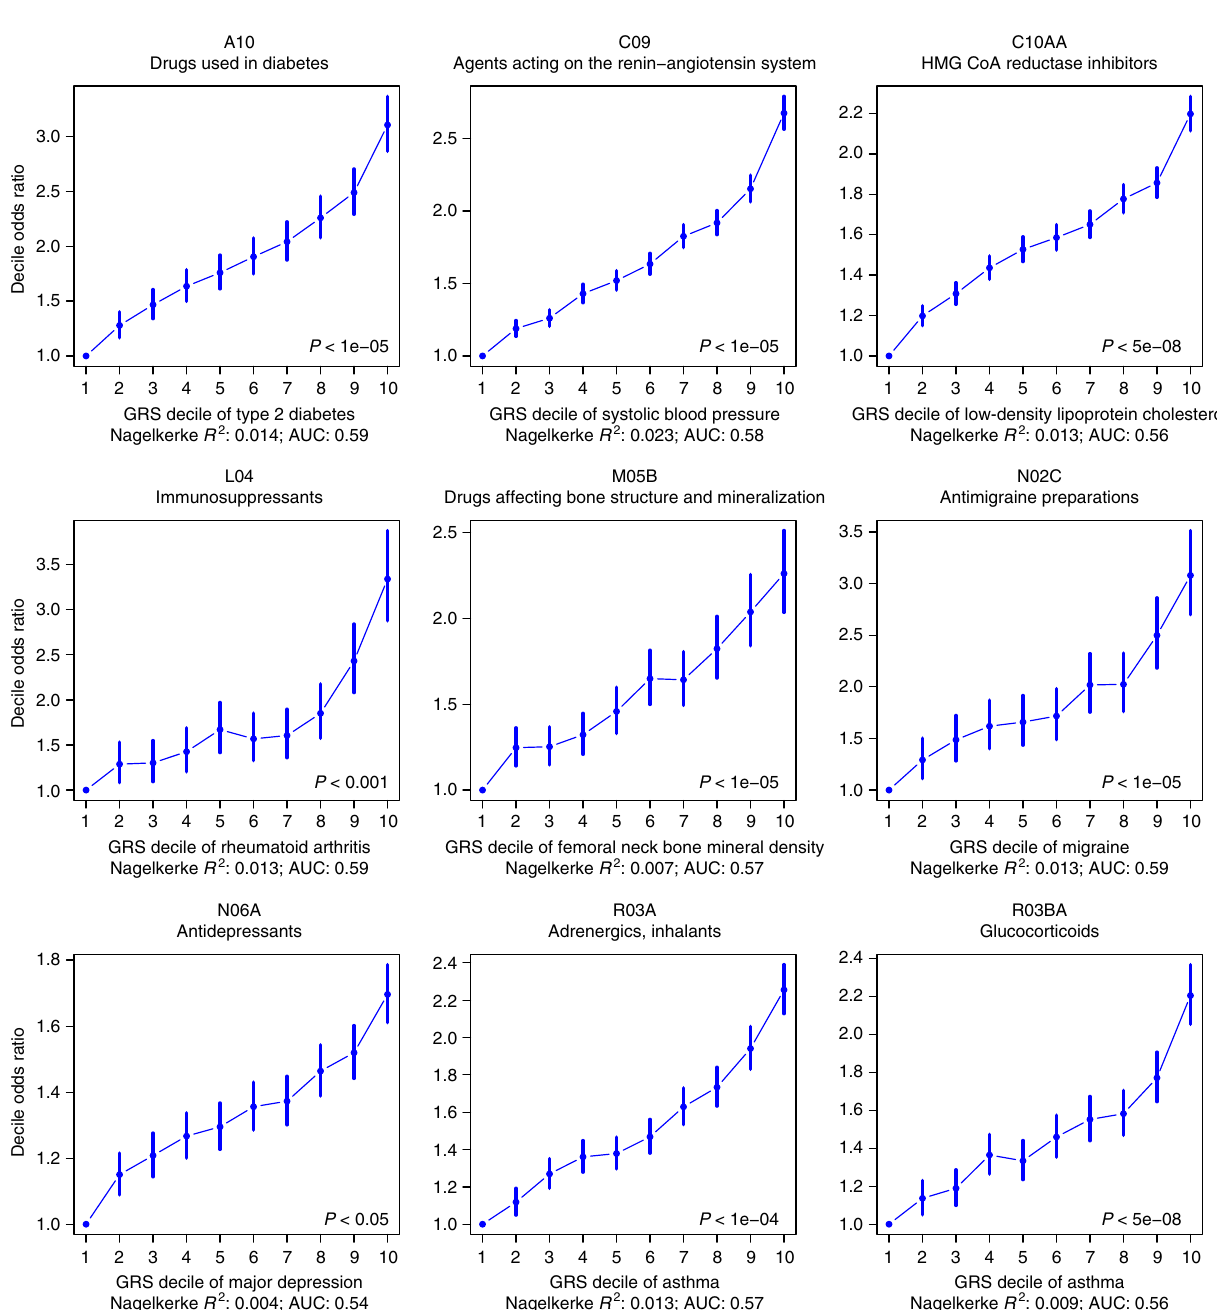
Fig. 3 Odds ratio (OR) by genetic risk score (GRS) pro fi le decile. GRS were converted to deciles (1 = lowest, 10 = highest). OR and 95% con fi dence intervals (blue bars) relative to decile 1 were estimated using logistic regression. The P value in the bottom right hand corner of each plot refers to the P value threshold in the discovery sample used to generate the GRS. Nagelkerke R 2 represents the proportion of variance of medication-taking explained by the GRS in logistic regression. Note: An increased GRS of femoral neck bone mineral density implies a lower